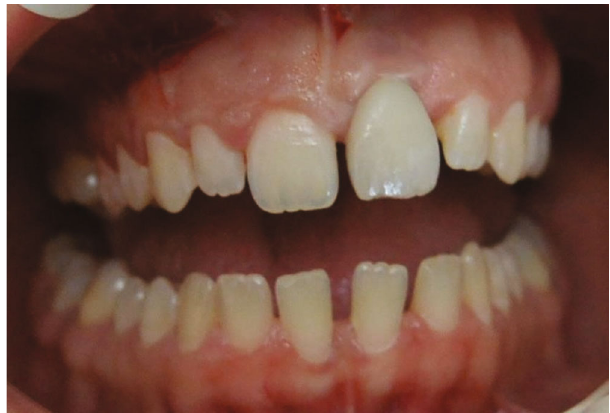
Figure 4: During the day 30 examination it was possible to see that the tissues had descended by at least 1.5mm and were beginning to de fi ne the possibility of a new emergent pro fi